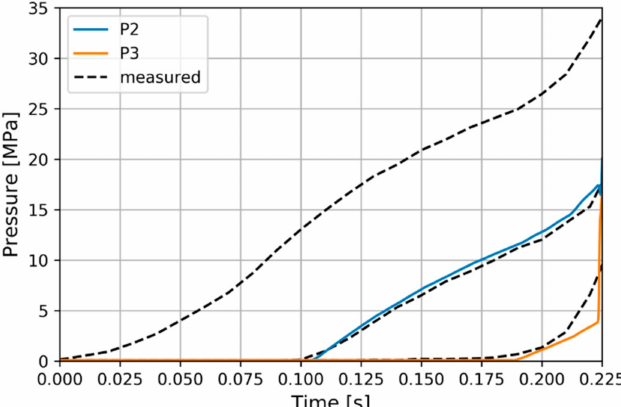
Figure 7. Filling pressure evolutions at the experimental